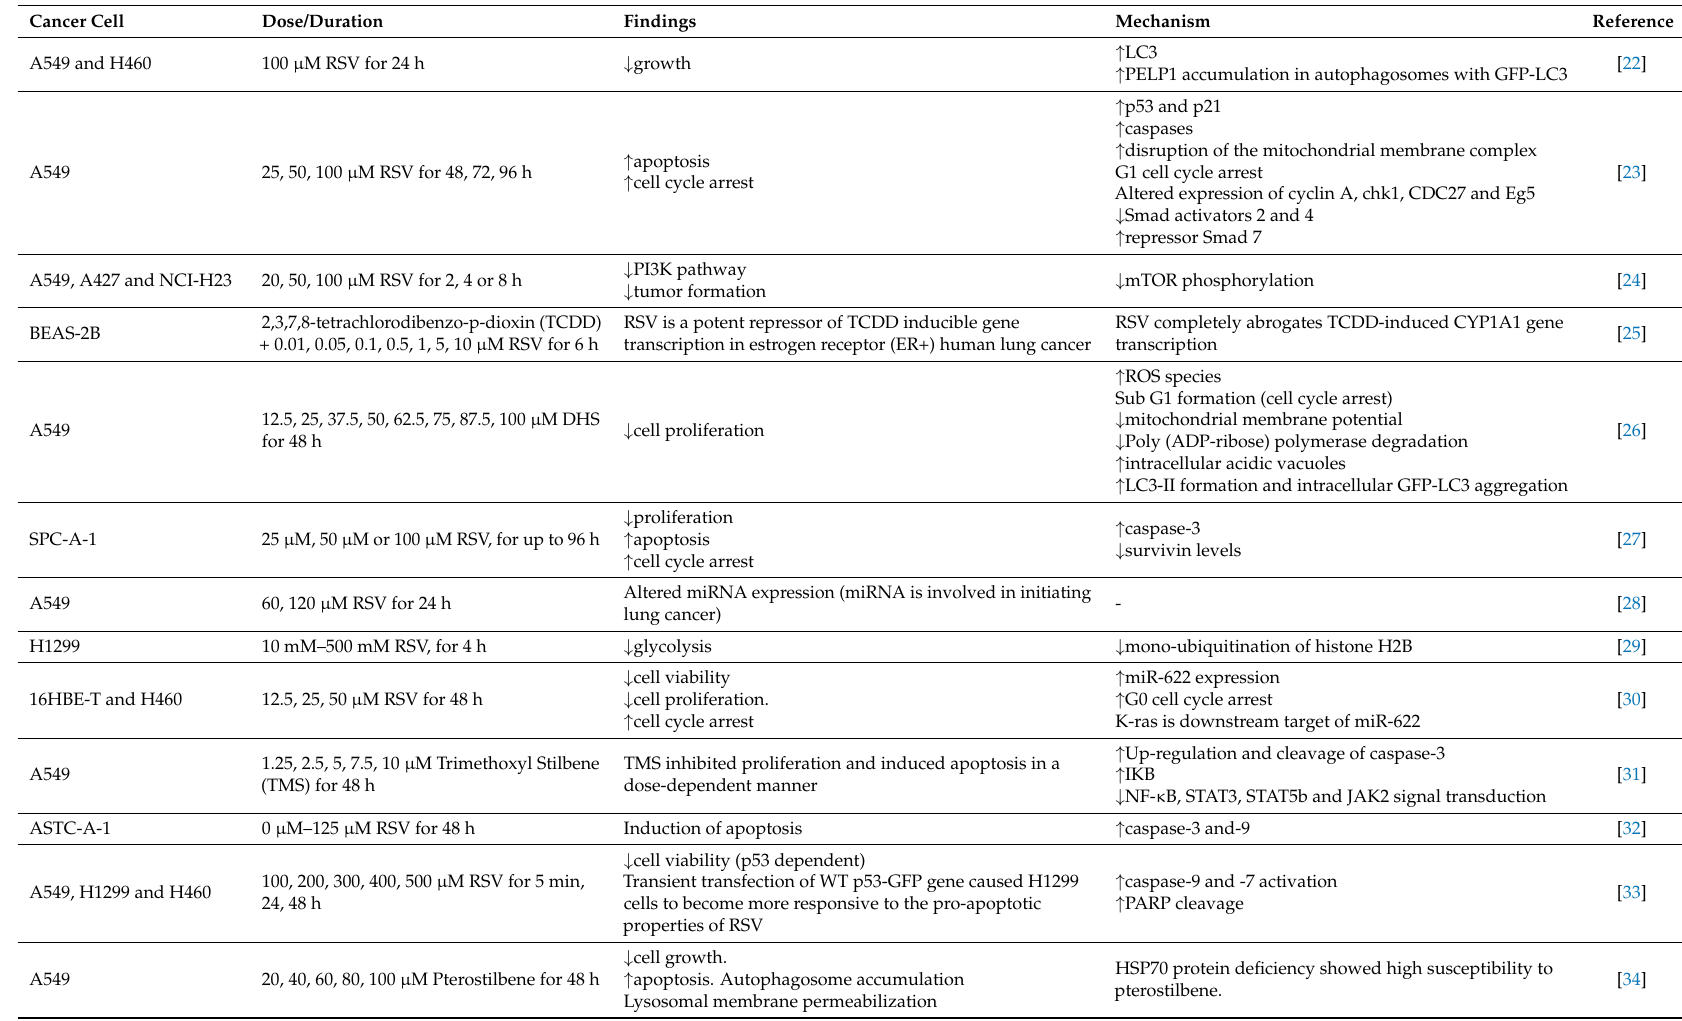
Table 1. Effects of resveratrol (RSV) as a single agent against lung cancer: in vitro